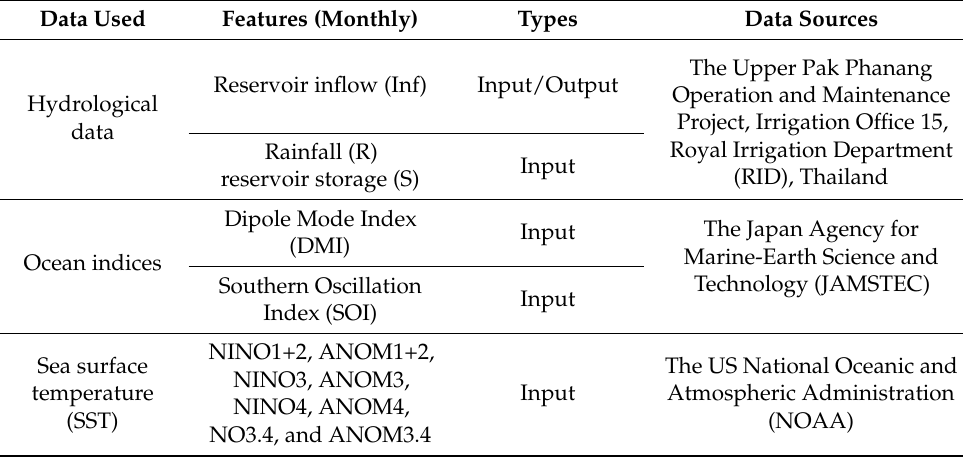
Table 2. The information of the data used, features, and data sources.